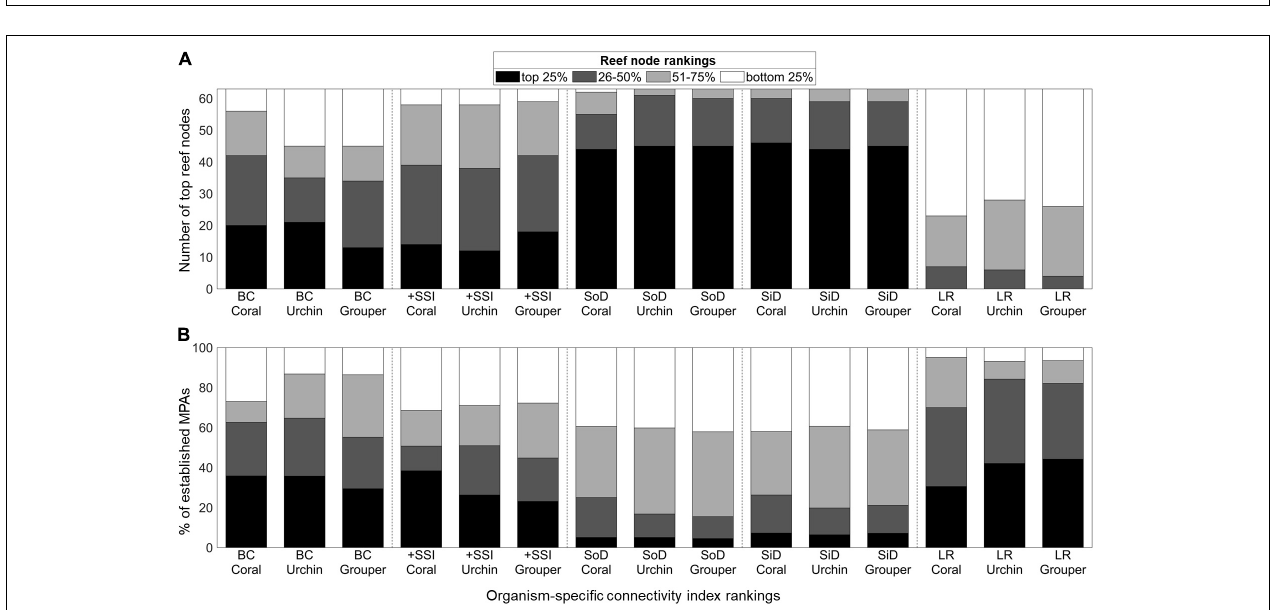
FIGURE 4 | Distribution of the organism-specific connectivity index rankings of the (A) overall top 25% of reef nodes and (B) 1,060 established MPAs (B) . The scale indicates the quartile ranking of the reef node or MPA. BC, Betweenness Centrality; +SSI, Source-Sink Index; SoD, Source Diversity; SiD, Sink Diversity; LR, Local